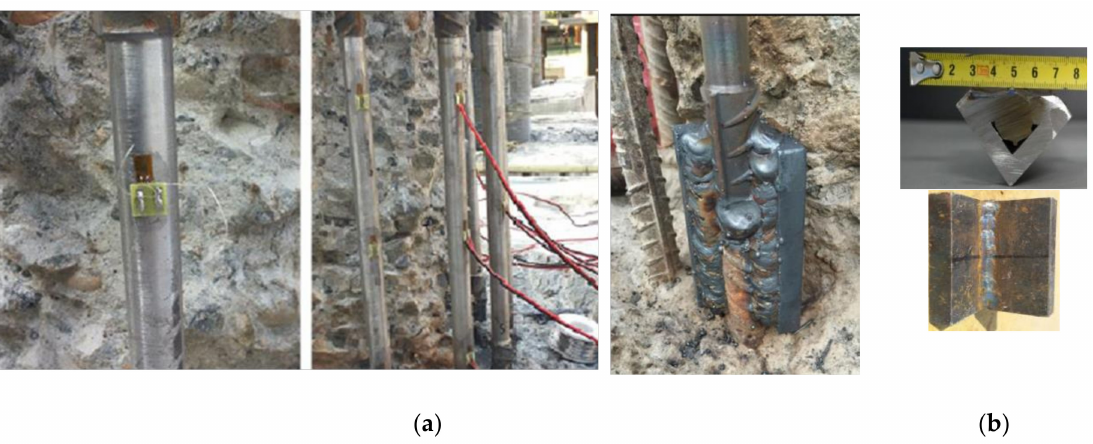
Figure 9. Damaged longitudinal rebar substitution: ( a ) Turned rebar geometries; and ( b ) rebar connection